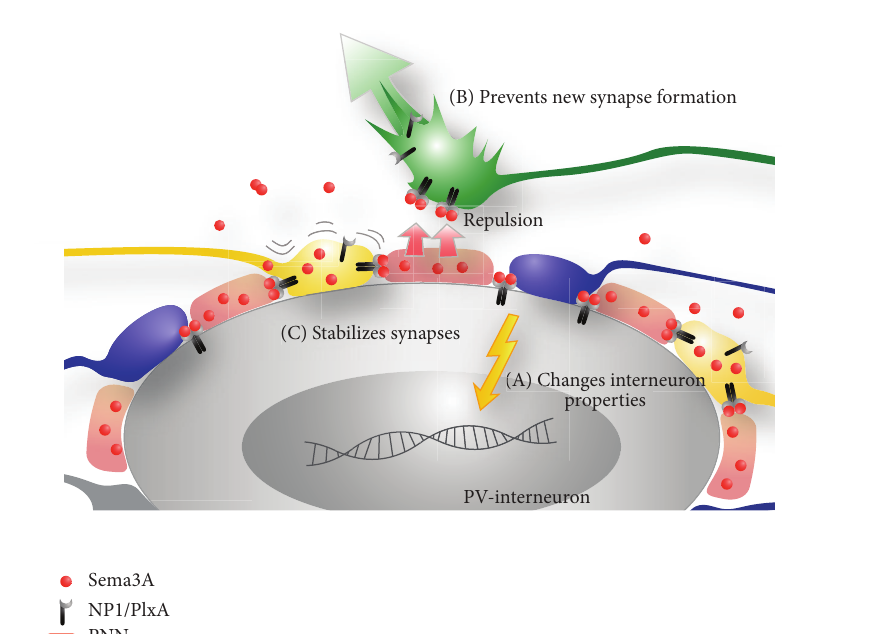
Figure 6: Schematic view of possible roles for Sema3A in PNN related plasticity. Sema3A protein molecules (red spheres) derived from the more distant cells in the environment, that is, meningeal cell or cells of the choroid plexus, or secreted along axons or by presynaptic terminals (yellow) integrate in the PNN surrounding parvalbumin (PV) positive interneurons. PV-interneurons express Sema3A receptor components (NP1/PlxA) which may trigger an internal response upon Sema3A binding that eventually may change the properties of the PV cell (A). Alternatively, Sema3A may act on (new) presynaptic terminals. Sema3A bound to the PNN may repel growing axons (green) away from the PV cell membrane and thereby prevent the formation of new synapses between PV-interneurons and ingrowing axons (B). Sema3A in the PNN may also “stabilize” synaptic contacts on the PV-interneuron surface by preventing local rearrangements of existing synaptic terminals